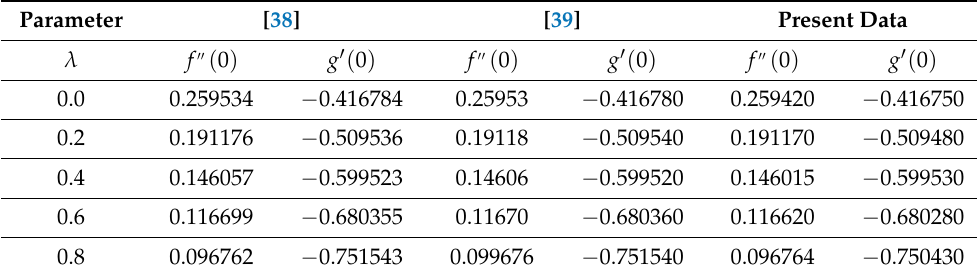
Table 3. Numerical values of skin frictions for values of an inertial factor λ with ε = 2.25.